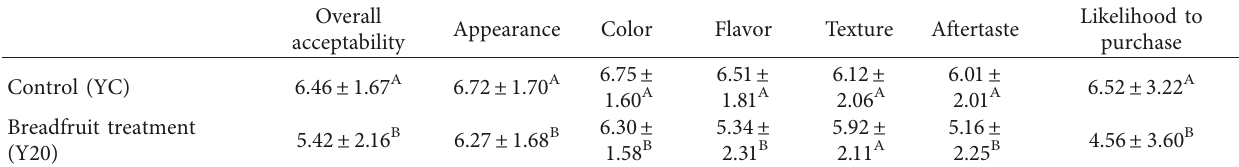
Table 6: Mean response of general panelist population to YC and Y20